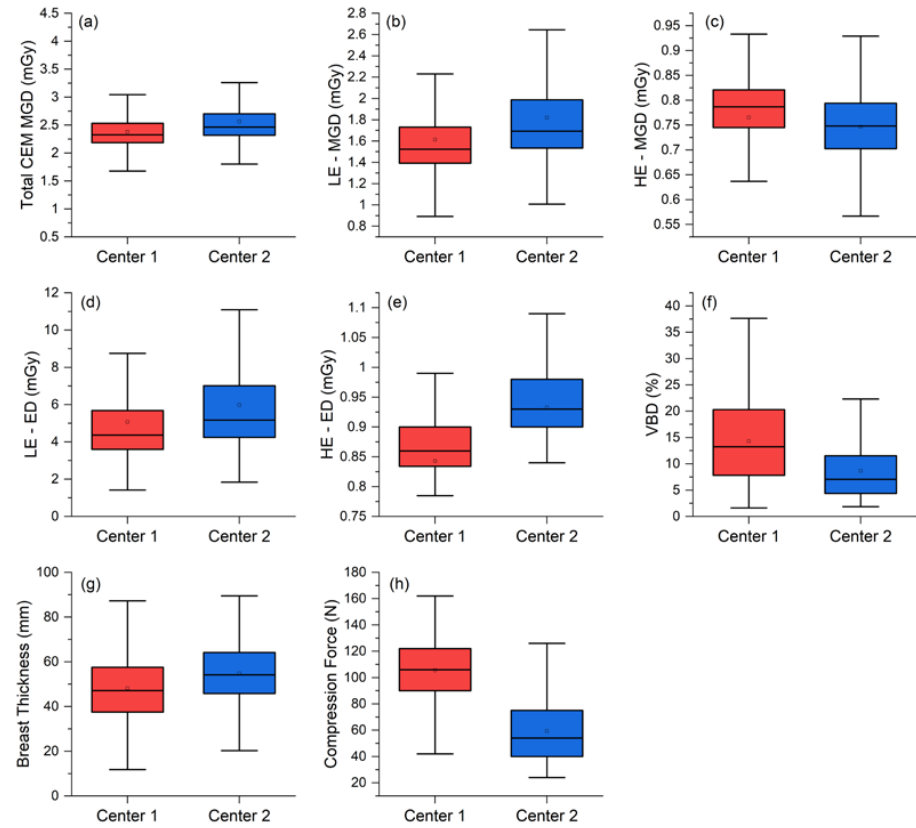
Figure 3. ( a ) Comparison between LE-noise components as a function of ED between the two cen- ters. ( b ) Comparison between HE-noise components as a function of ED between the two centers.